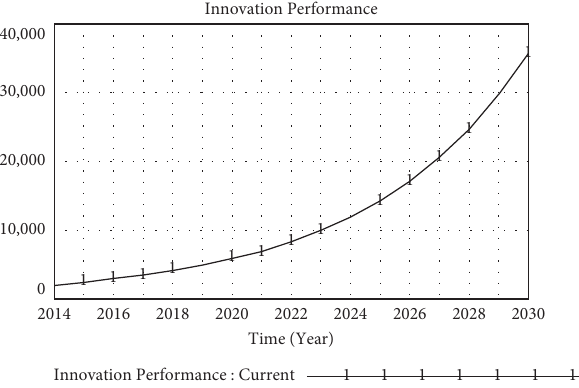
Figure 4: Trends in innovation performance.